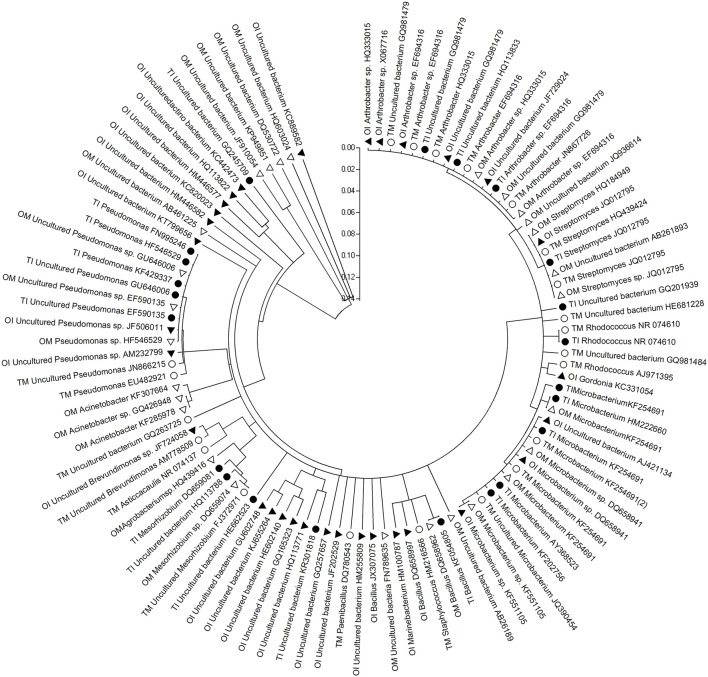
Phylogenetic analysis based on partial bacterial 16S rDNA sequence derived from the PMB of rhizosphere soil of tomato and potato onion grown as monocrops and intercrops at 37 DAT. Distances and clustering with the neighbor-joining method was performed by using the molecular evolutionary genetics analysis software version 4.0. TM, tomato monoculture(•); TI, tomato intercropping with potato onion(•); OM, potato onion monoculture(Δ); OI, potato onion intercropping with tomato(▴).